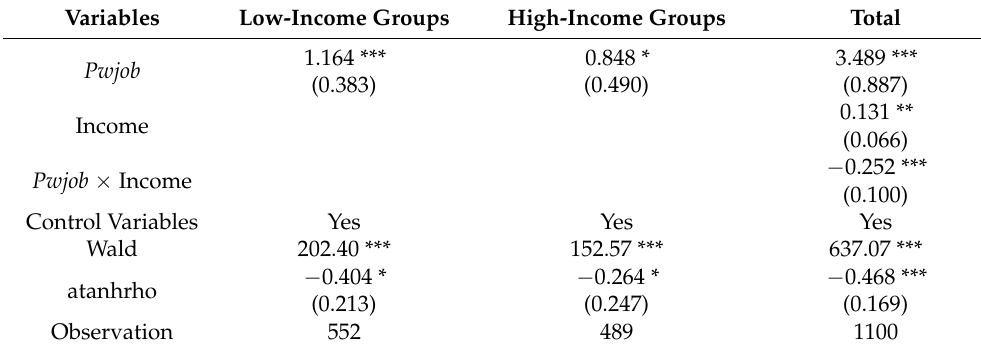
Table 8. Results of the income heterogeneity